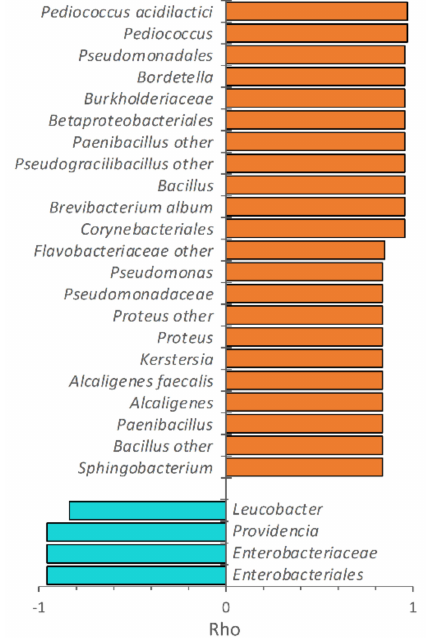
Figure 4. Spearman’s rank correlation of the bacterial taxa in PP and the growth temperature. The correlation coe ffi cient rho is reported only for the taxa exhibiting a positive (orange) or negative (cyan) significant correlation with temperature and appearing at least once with abundance > 1.0% ( n = 2, p <